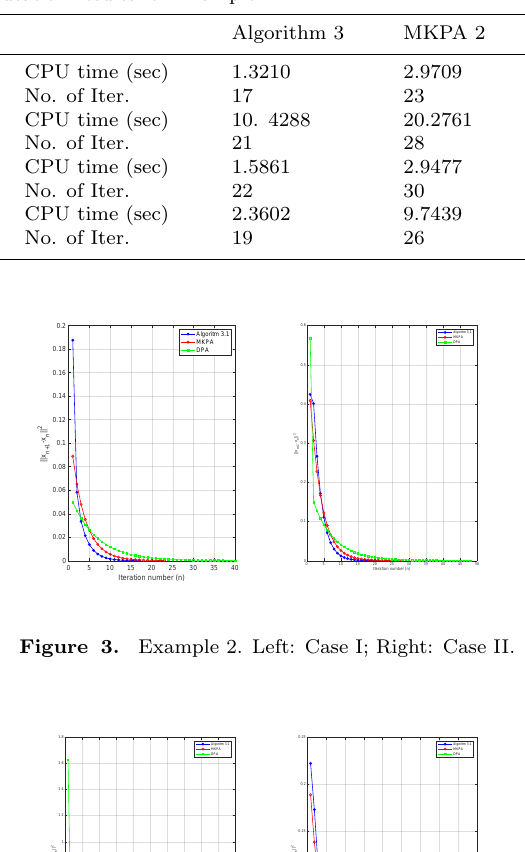
Table 2. Computation results for Example 2.